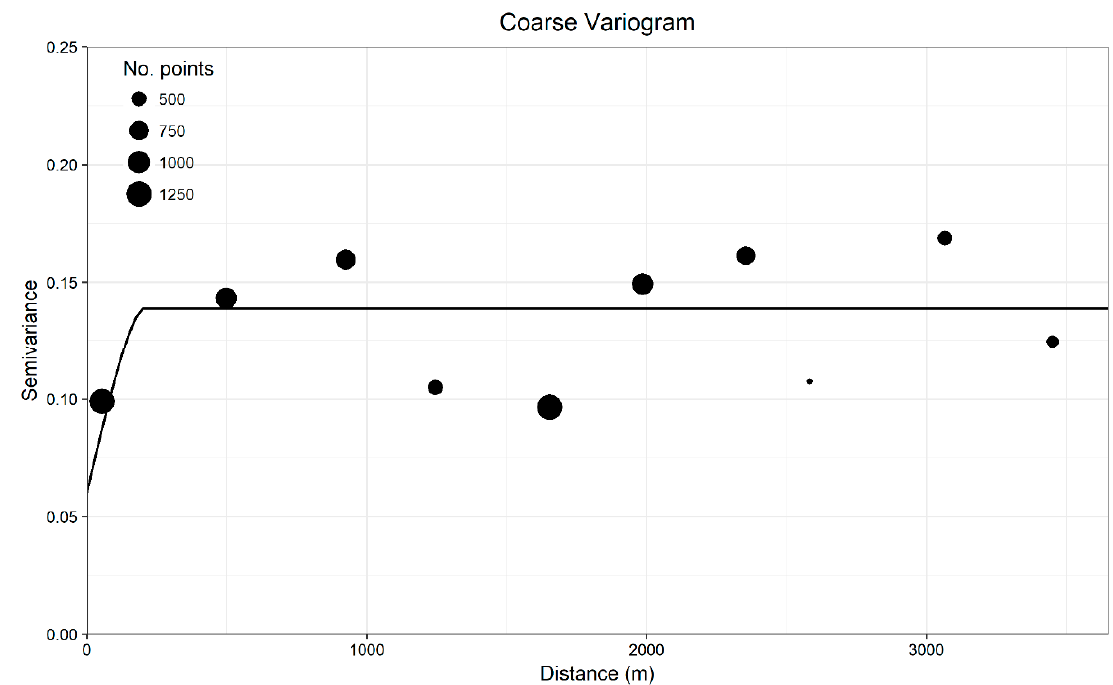
Figure A4. Coarse substrate variogram circular model with 360 m lags; nugget = 0.0603, partial sill = 0.0786, major range = 199.12 m.